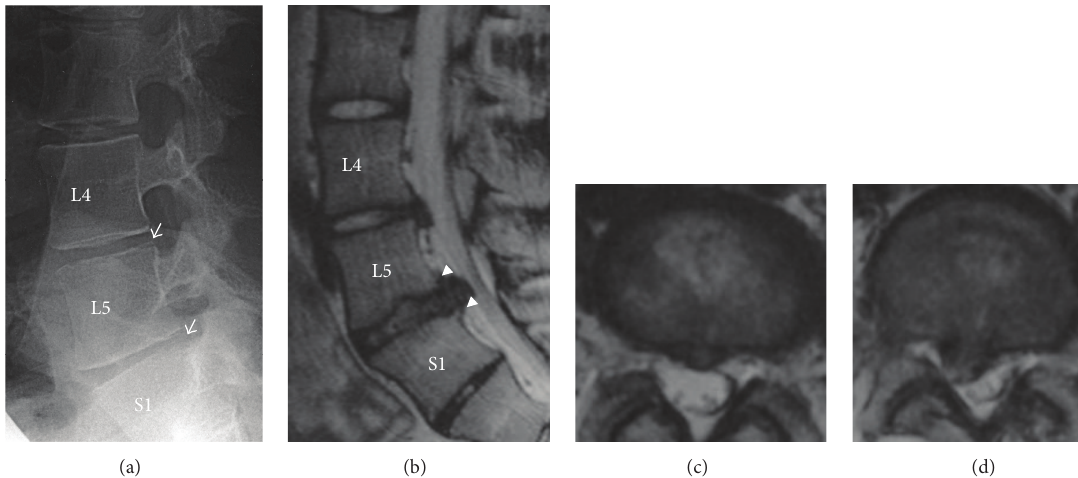
Figure 1: Radiographs showed lumbar posterior endplate lesions at L4/5 and L5/S1 at 14 years of age ((a), white arrows). Sagittal (b) and axial ((c) and (d)) T2-weighted MR images revealed L4/5 and L5/S1 lumbar disc herniation with endplate lesion. White arrow head showed irregular shape of the posterior end plate at the corner of S1 and L5 vertebrae.